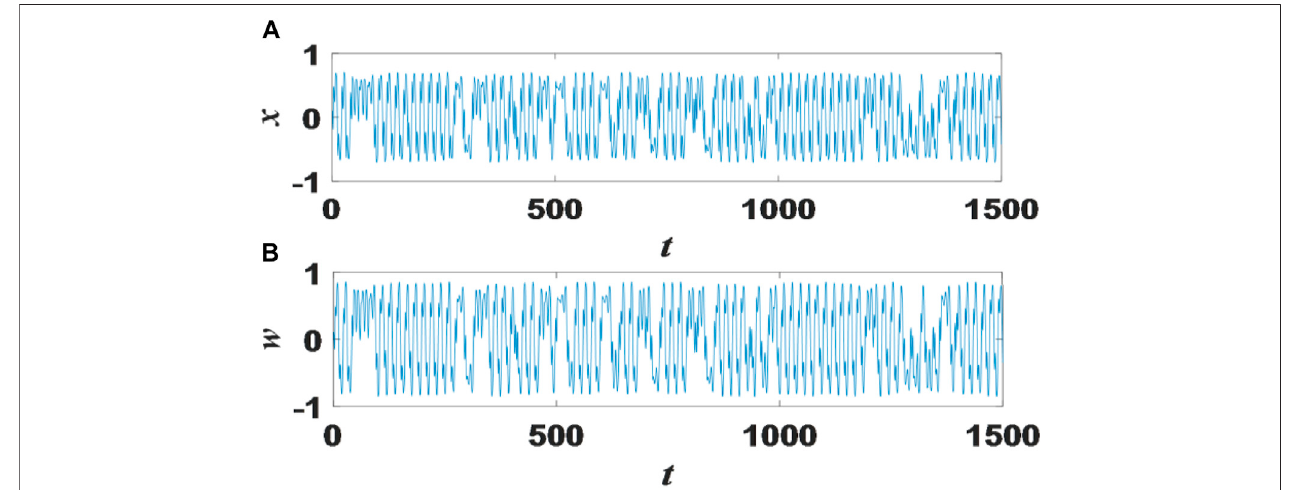
FIGURE 3 | Display the time series diagram of state variables x and w . (A) the time series of state variables x (B) the time series of state variables w .